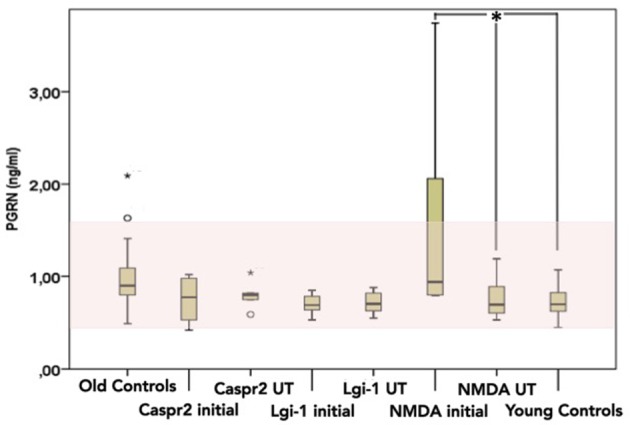
CSF Progranulin levels [pg/ml] in patients with AE (n = 36) measured divided by antibody and by phase of disease (initial vs. under treatment). Significant results are marked with a *. Normal range is marked in light red. Line represents the median and the error bars represent the interquartile range. Black points are outliers.